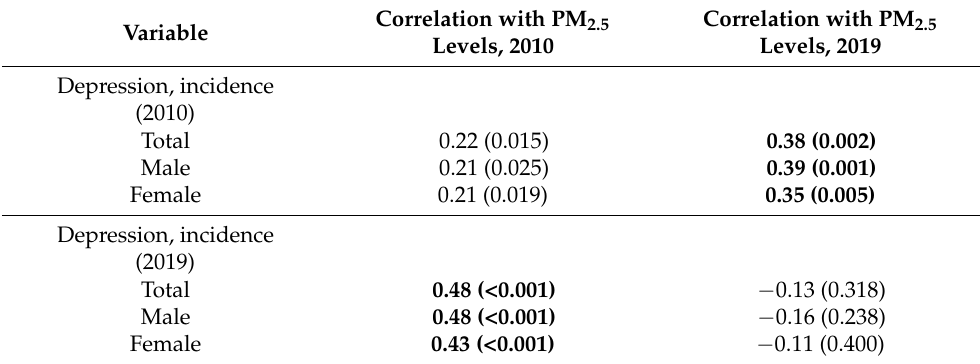
Table 3. Bivariate correlations between average annual PM 2.5 and the incidence of depression, grouped according to WHO safety guidelines. Correlation with PM 2.5 Correlation with PM Variable Levels, 2010